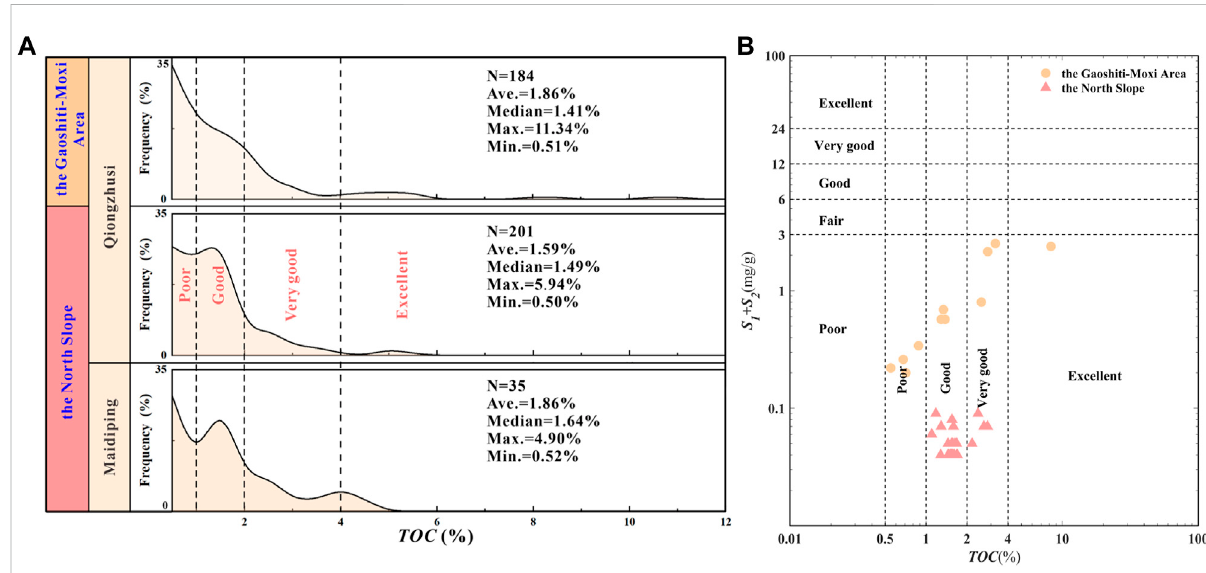
FIGURE 4 A comprehensive comparison of Lower Cambrian source rocks on the North Slope and in Gaoshiti-Moxi. (A) Comparing the qualities of Lower Cambrian source rocks (the Qiongzhusi and Maidiping Formations) on the North Slope and in the Gaoshiti-Moxi area. (B) Source rocks in Taihe and Gaoshiti-Moxi are primarily good-excellent, but Taihe ’ s average quality is better than those in Gaoshiti-Moxi, according to TOC and S 1 +S 2 .